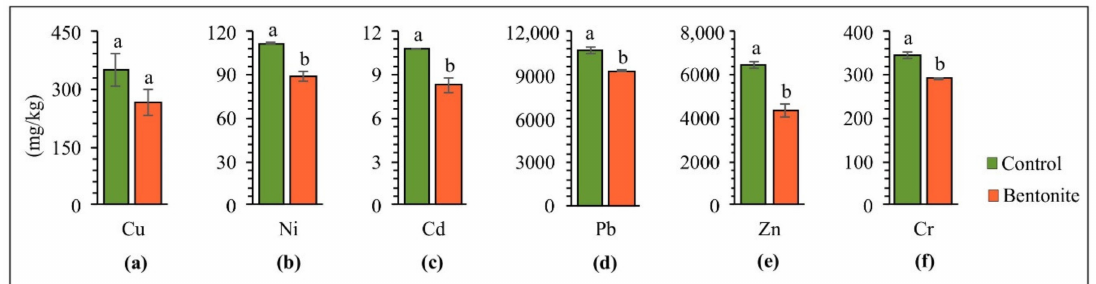
Figure 2. Soil HM composition after bentonite-assisted phytostabilization: ( a ) Cu, ( b ) Ni, ( c ) Cd, ( d ) Pb, ( e ) Zn, ( f ) Cr. Different letters indicate significant differences ( p < 0.05) between the control and bentonite